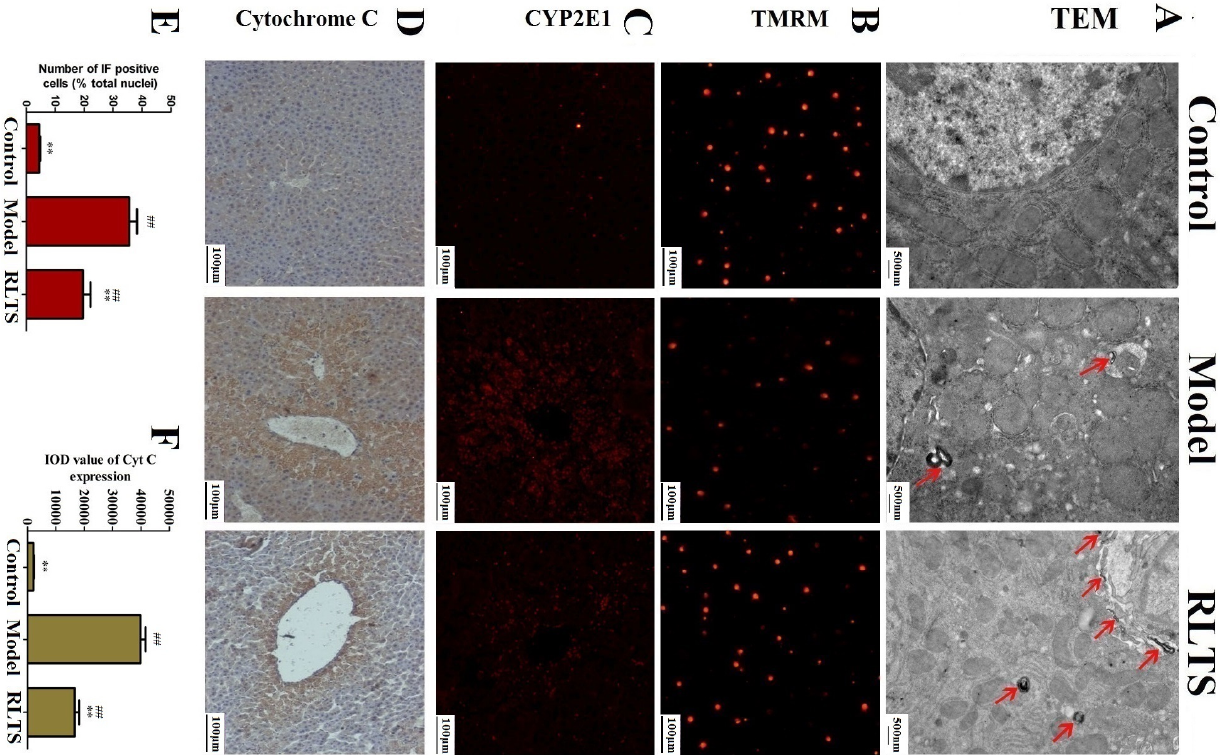
Figure 4. TEM analysis of the livers (magnification, 25,000×) in normal, model and RLTS (300 mg/kg) groups, and the arrows indicated autophagosome ( A ). Mitochondrial membrane potential detected by TMRM staining ( B ). Effects of RLTS (300 mg/kg) on the expression of CYP2E1 ( C ) and cytochrome C ( D ) (magnification, 200×). Statistical analysis of the fluorescence intensity ( E ) and the integrated optical density ( F ). Values are expressed as mean ± SD ( n = 4). ** p < 0.01 vs. model group; ## p < 0.01 vs. normal